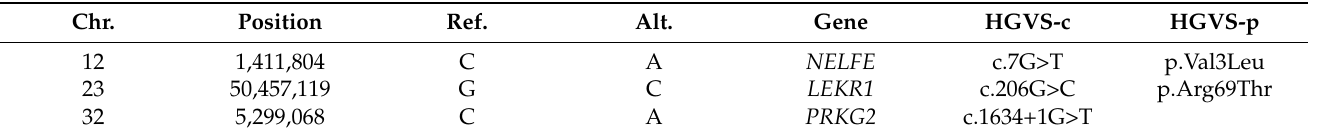
Table 2. Details of three private protein-changing candidate variants.